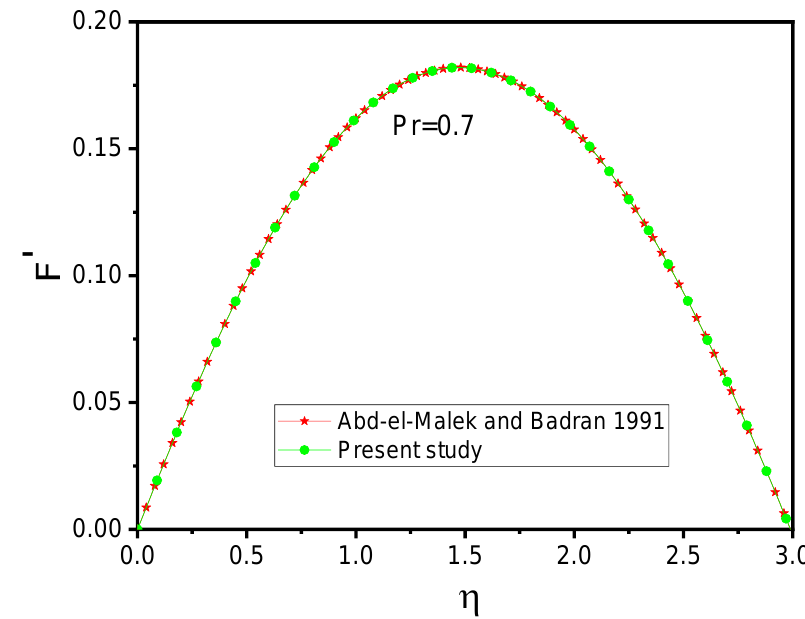
Figure 2. Comparison with [37] of F (cid:48) for Pr = 0.7 with β = Mn = Ec = Nr = φ = ' F for 0 7 = Pr . with 0 =====  NrEcMn .